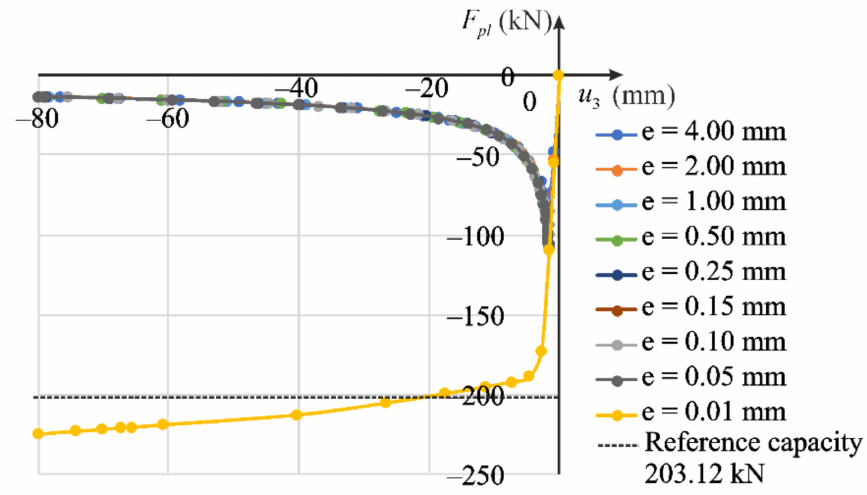
Figure 20. Axial force versus applied displacement for the nonlinear elastic model.